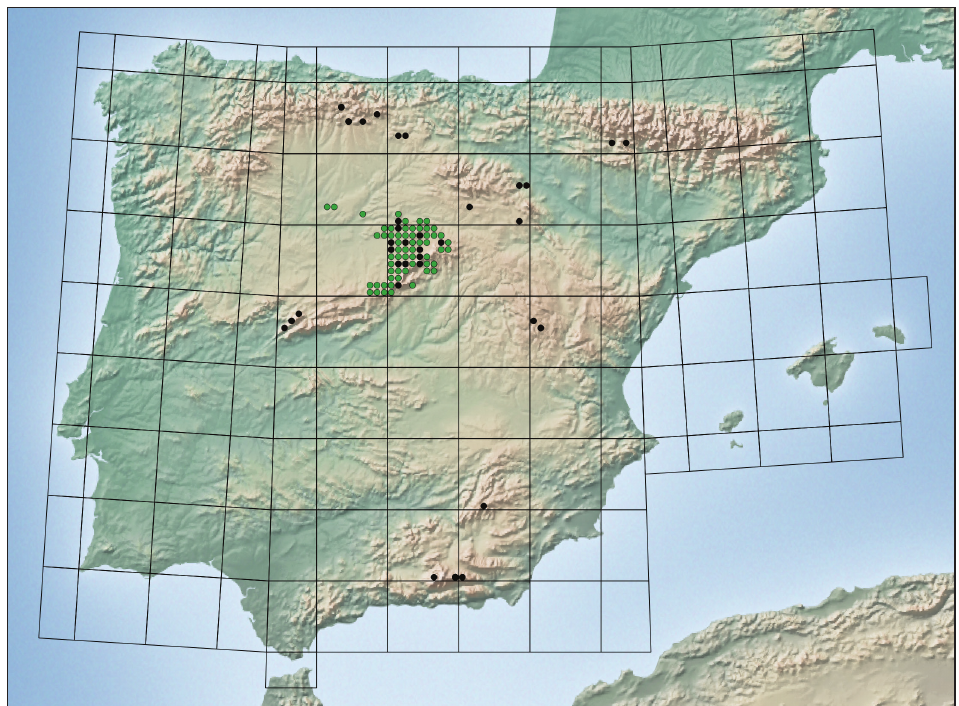
Figure 70. Distribution map of Spialia rosae in the Iberian Peninsula using 10 × 10 km squares of the MGRS system. Black circles represent records from the literature and green circles represent new records. Grid rep- resents UTM. 100 × 100 km, symbol size is 10